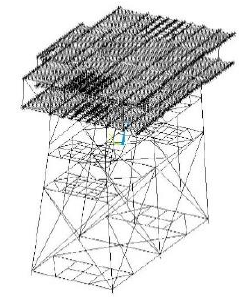
Figure 2. FEM of jacket platform.